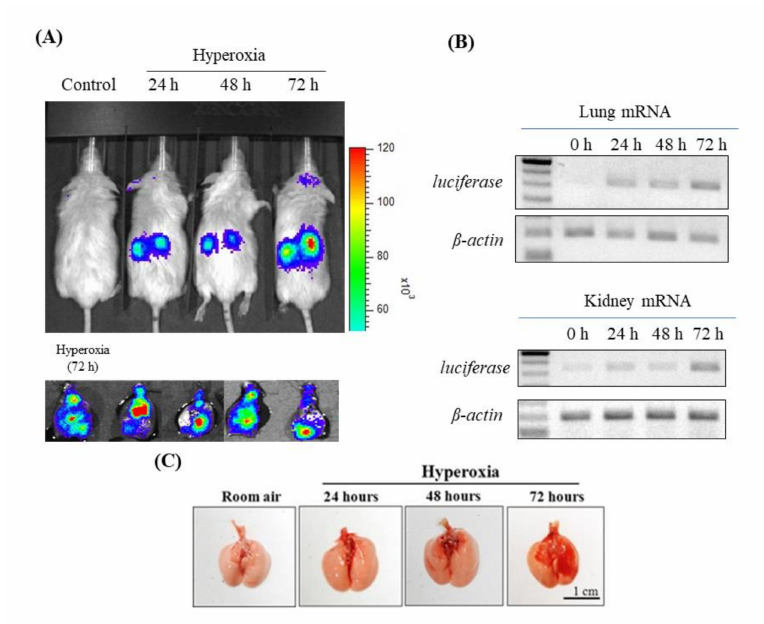
Figure 1. ( A ) Bioluminescence imaging of kidney and lung tissues; ( B ) luciferase mRNA expression of lung and kidney tissues; and ( C ) histopathological analyses of lung tissues in NF- κ B–luciferase transgenic mice after induction of hyperoxia for 0, 24, 48 and 72 h.